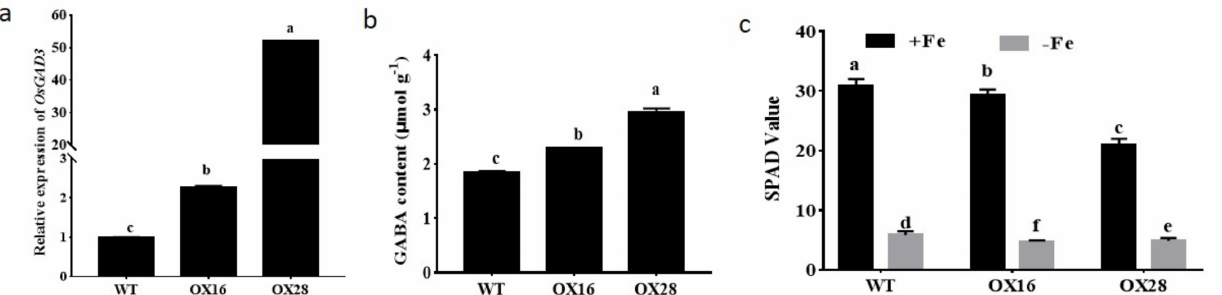
Figure 2. Relative expression of OsGAD3 , GABA contents and the SPAD Value in wild type and over-expression lines OX16 and OX28. (a ) Relative expression of OsGAD3 . ( b ) GABA contents. Data are the means ± SD (n=3). ( c ) The SPAD value in different lines under conditions of FS and FD. Data are the means ± SD ( n = 10). Different letters denote a remarkable difference ( p ≤